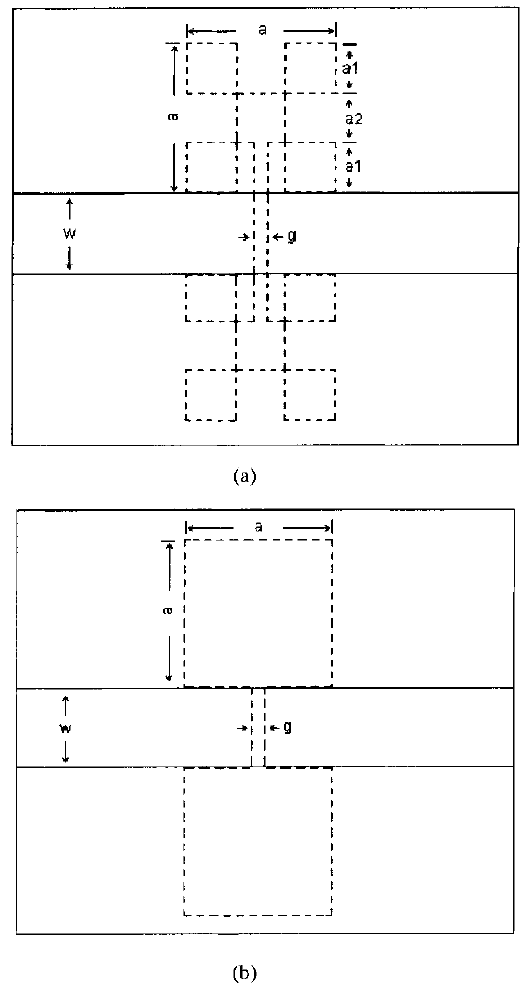
FIGURE 1 Schematic of microstrip line with DGS. a ¼ 4.5mm, w ¼ 2.4mm, and g ¼ 0.4mm. (a) Fractal DGS (